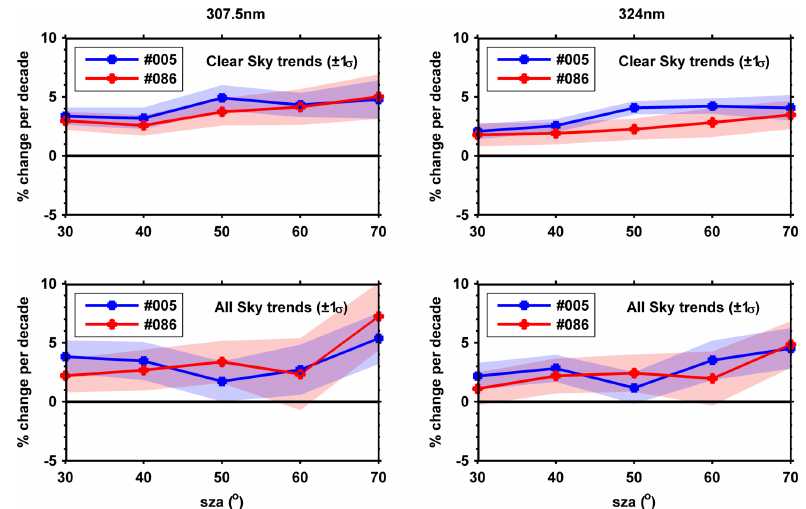
Figure 2. Linear trends (in % per decade) of spectral UV irradiance at 307.5nm (left) and 324nm (right) for clear-sky (upper) and all-sky (lower) conditions derived from Brewers #086 and #005, as a function of solar zenith angle. The shaded areas represent the ± 1 σ uncertainty of the derived trends.